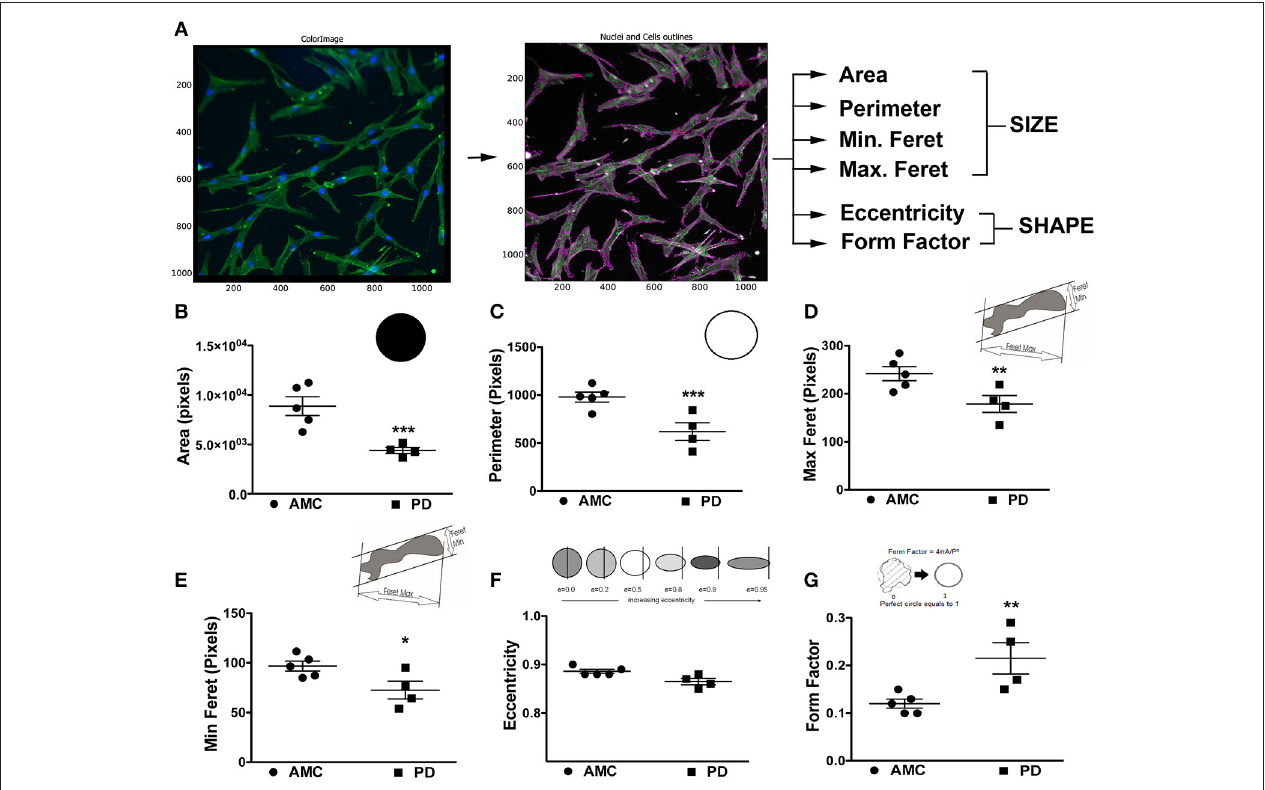
FIGURE 2 | Cellular Size and Shape analysis of PD and AMC fibroblasts (A) Sample CellProfiler image showing outlines of “cell objects” according to fluorescence Phalloidin and Dapi stains and the list of parameters used to quantify size and shape. Quantification of cellular area (B) , perimeter (C) , maximum ferret ( D , measuring the predicted length of the object across planes), minimum ferret ( E , measuring the predicted width of each object across planes), eccentricity ( F , arbitrary value for roundness), and form factor ( G , arbitrary value on how defined the outline of an object is) in PD and AMC cultures. * p < 0.05, ** p < 0.01, *** p < 0.001; Mean ± SEM, Unpaired t -tests with Welch’s correction, n = 4–5 independent PD and AMC